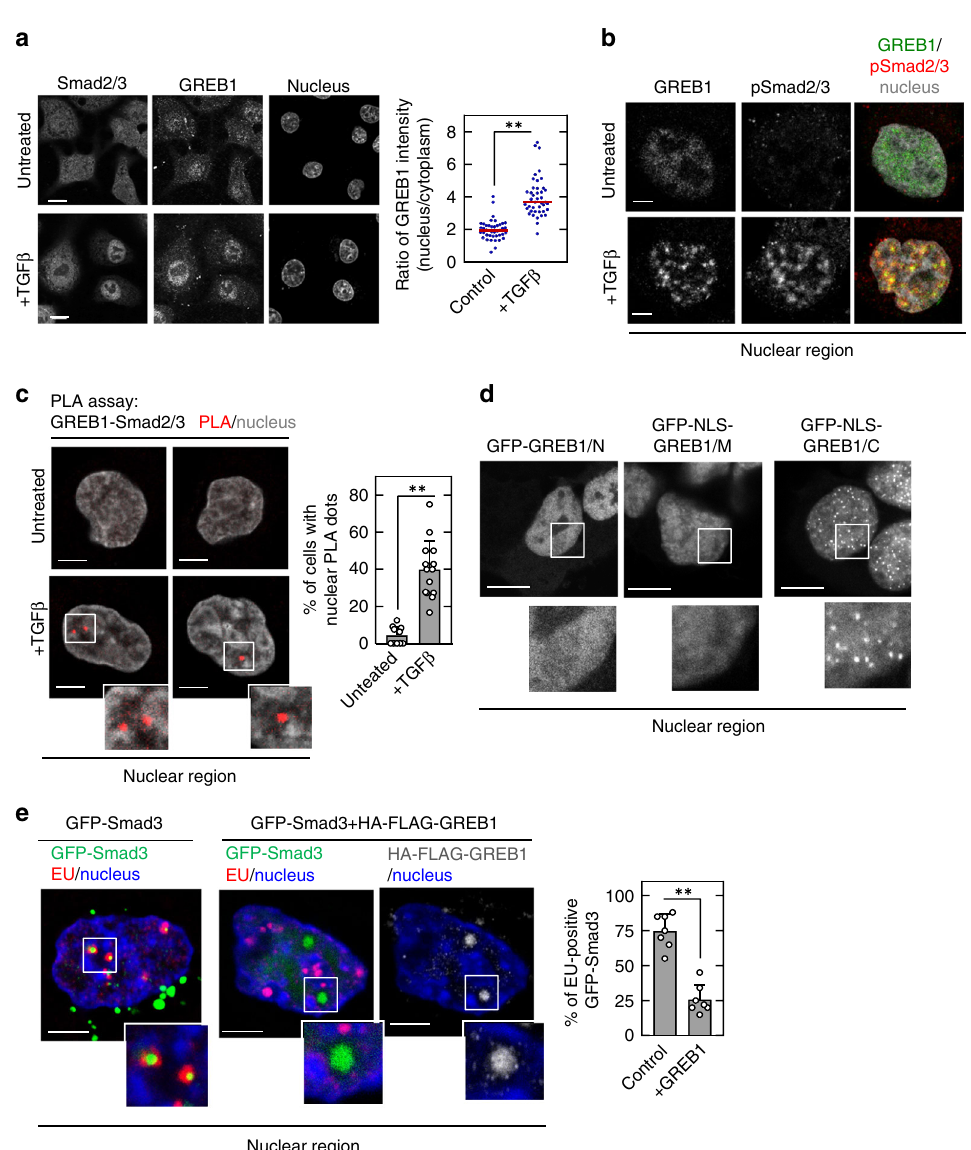
Fig. 5 Interaction of GREB1 and Smad2/3 in the nucleus inhibits Smad-dependent transcription. a HepG2 cells were untreated or treated with 10 ng/ml TGF β for 30 min, followed by staining with the indicated antibodies and Hoechst33342. GREB1 fl uorescence intensity in the nucleus and cytoplasm was measured and the results are expressed as the ratio of nuclear to cytoplasmic GREB1. ** P < 0.01, t test. b HepG2 cells were untreated or treated with TGF β , and cells were then stained with the indicated antibodies and Hoechst33342. c HepG2 cells were untreated or treated with TGF β , followed by incubation with mouse anti-GREB1 and rabbit anti-Smad2/3 antibodies, which were then combined with secondary PLA probes. Interaction events are shown as red dots. Cells with PLA dots were counted, and the results are expressed as the percentage of total cells per fi eld ( n > 100). The regions in the solid squares are shown enlarged. ** P < 0.01, t test. d HepG2 cells expressing deletion mutants of GFP-GREB1 were stained with anti-GFP antibody. The regions in the solid squares are shown enlarged. e HepG2 cells expressing GFP-Smad3 with or without HA-FLAG-GREB1 were incubated with EU for 30 min before fi xation. Cells were stained with the indicated antibodies and Hoechst33342. The regions in the solid squares are shown enlarged. ** P < 0.01, t test. Scale bars in a and d , 10 μ m; in b , c , and e , 5 μ